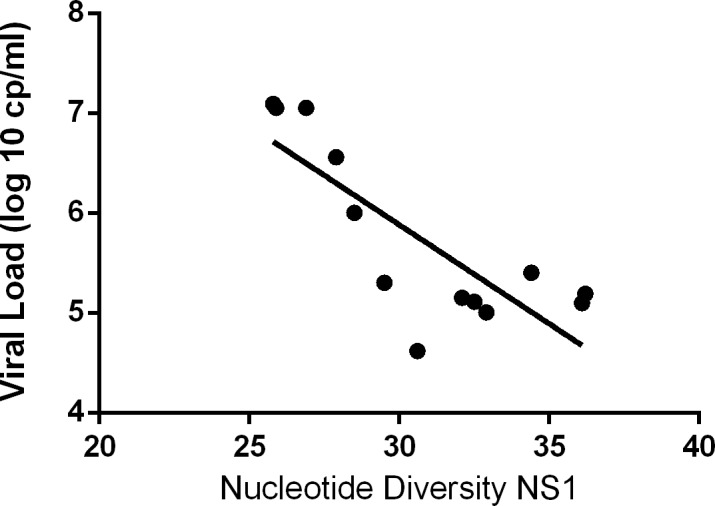
Correlation between nucleotide diversity of NS1 and viral load.On x-axis, NS1 nucleotide diversity, expressed as Nucleotide Substitution/Site X 10−4; on y-axis, viral load expressed as log10 copies/mL.